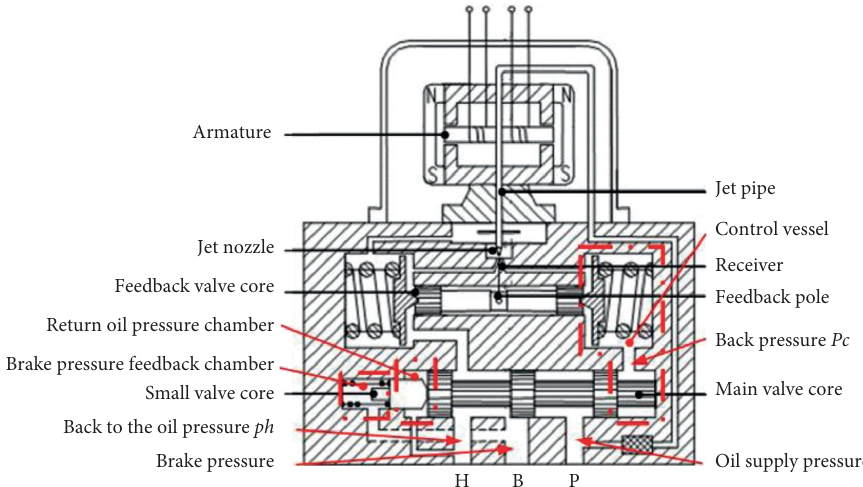
Figure 1: Brake pressure servo valve